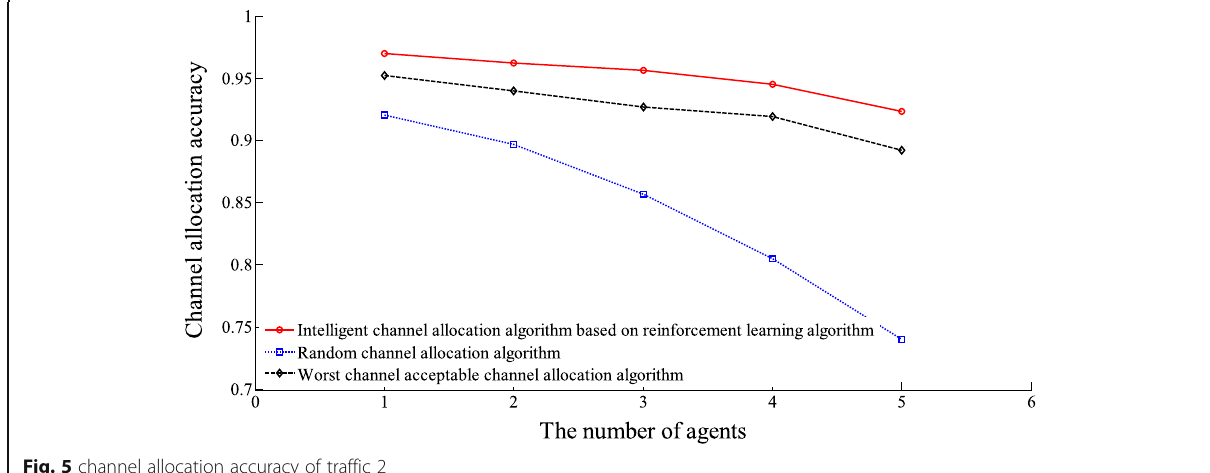
Fig. 5 channel allocation accuracy of traffic